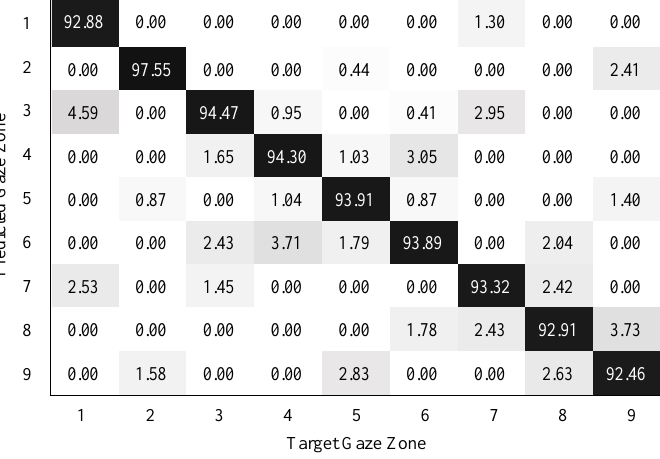
Figure 13. Gaze zone classification results based on the proposed method and SVM